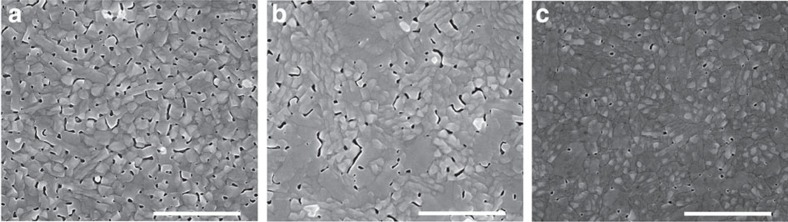
Morphology of CsPbBr3 films deposited under different conditions.(a–c) Planar SEM images of CsPbBr3 deposited on ZnO, ZnO/PVP and Cs0.87MA0.13PbBr3 on ZnO/PVP, respectively, here PVP is polyvinyl pyrrolidine. The scale bar is 2 μm in all images.